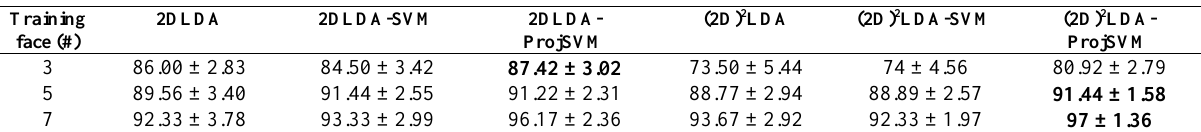
Table 5. Mean classification accuracy (in percent) over 10 random runs for Yale dataset with reduced dimension of 10 using 2DLDA and (2D) 2 LDA as dimensionality reduction methods.